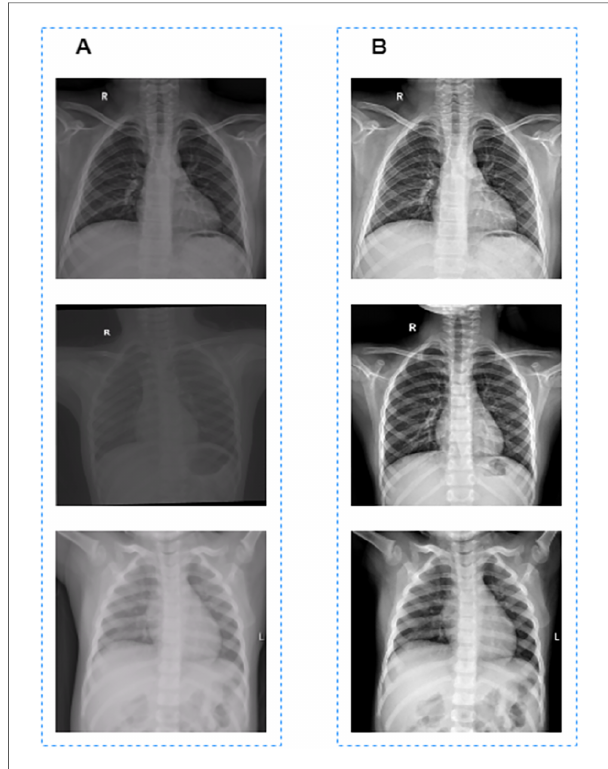
FIGURE 1 Image preprocessing results. ( A ) Images before grayscale truncation. ( B ) Images after grayscale truncation.